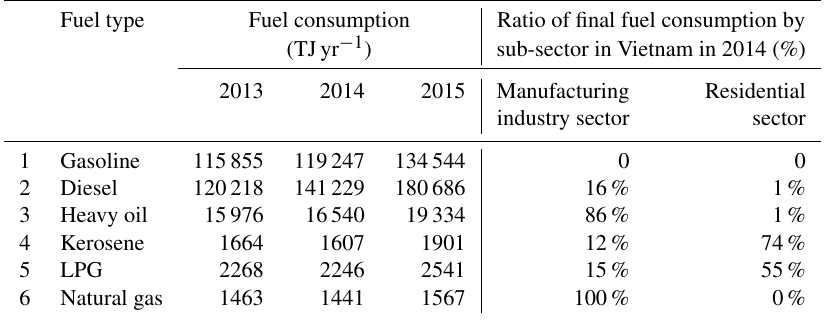
Table 6. Annual fuel consumption in HCMC (2013, 2014, 2015) and ratio of final fuel consumption by sub-sector (manufacturing industry and residential sectors) and fuel type in Vietnam in 2014 provided by JICA (2017a).